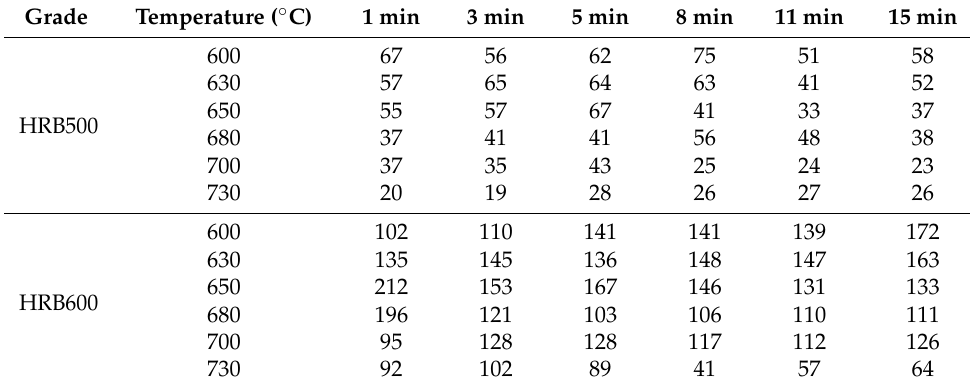
Table 3. The number of grains of ferrite in unit area (100 µ m × 100 µ m). Grade